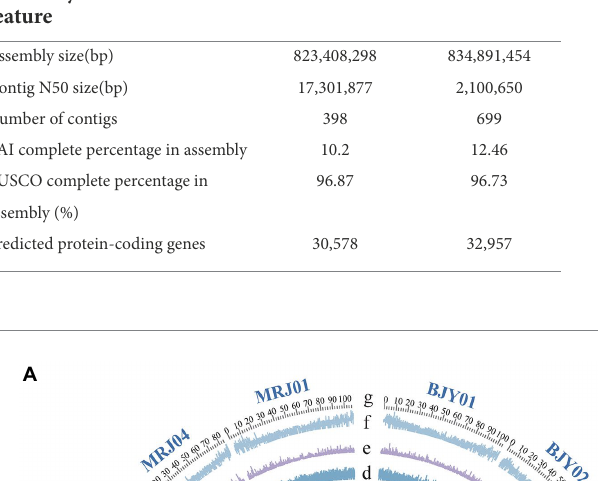
TABLE 1 Statistics for Canna edulis and Canna indica genome